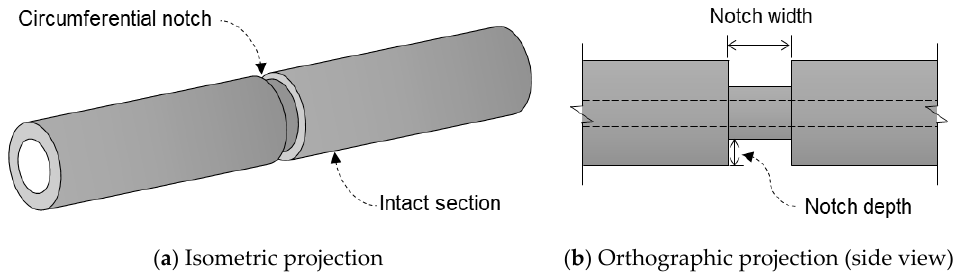
Figure 5. Geometry of the specimen.